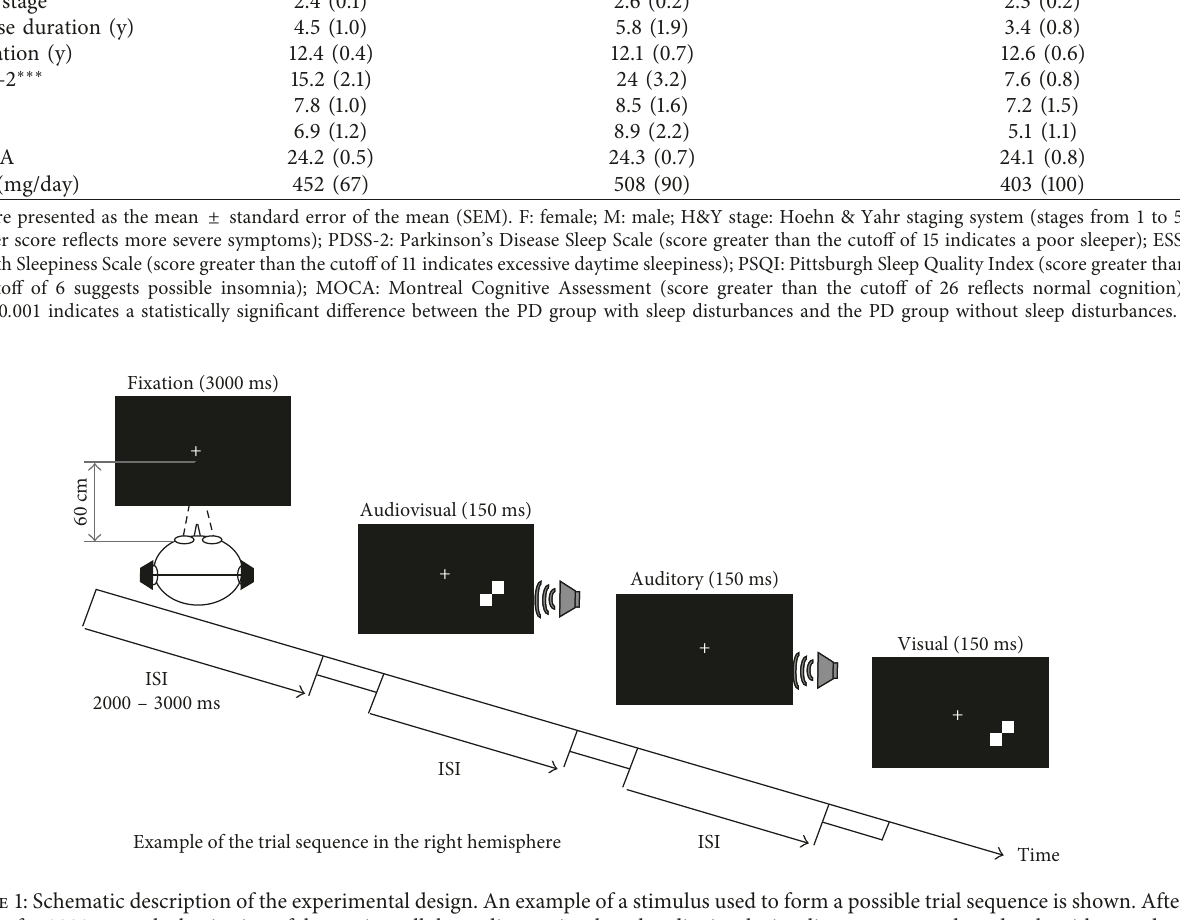
Figure 1: Schematic description of the experimental design. An example of a stimulus used to form a possible trial sequence is shown. After fixation for 3000 ms at the beginning of the session, all the auditory, visual, and audiovisual stimuli were presented randomly with a random interstimulus interval (ISI) of 2000–3000ms. Following the presentation of each stimulus, the subject was instructed to identify which hemispace was presented by pressing the right or left button of a mouse as rapidly and accurately as